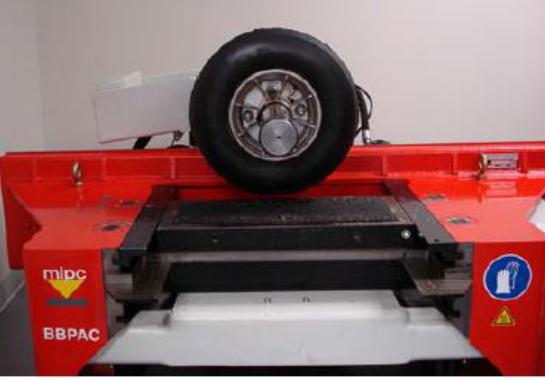
Figure 6. Photo of the Laboratoire Central des Ponts et Chaussées (LCPC) slab compactor.